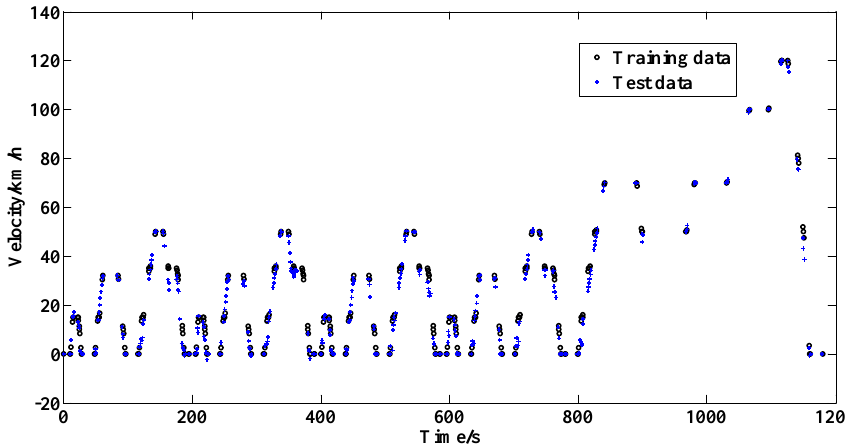
Figure 10. Training data of neural network and test data of NEDC.